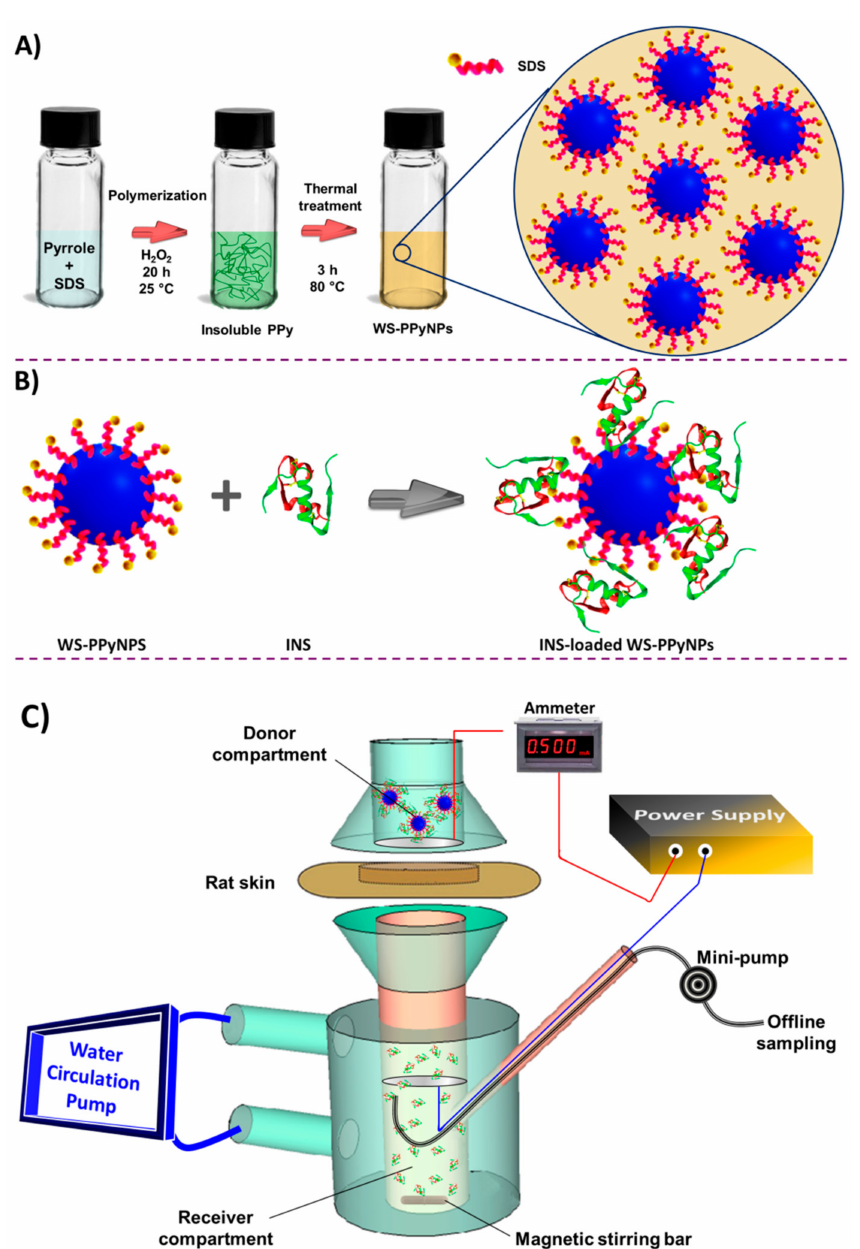
Figure 1. Schematic overview of main experimental procedures. ( A ) Schematic overview of step-by- step synthesis of WS-PPyNPs. ( B ) The preparation of INS-loaded WS-PPyNPs. ( C ) Experimental set up of in vitro controlled transdermal iontophoresis of INS-loaded